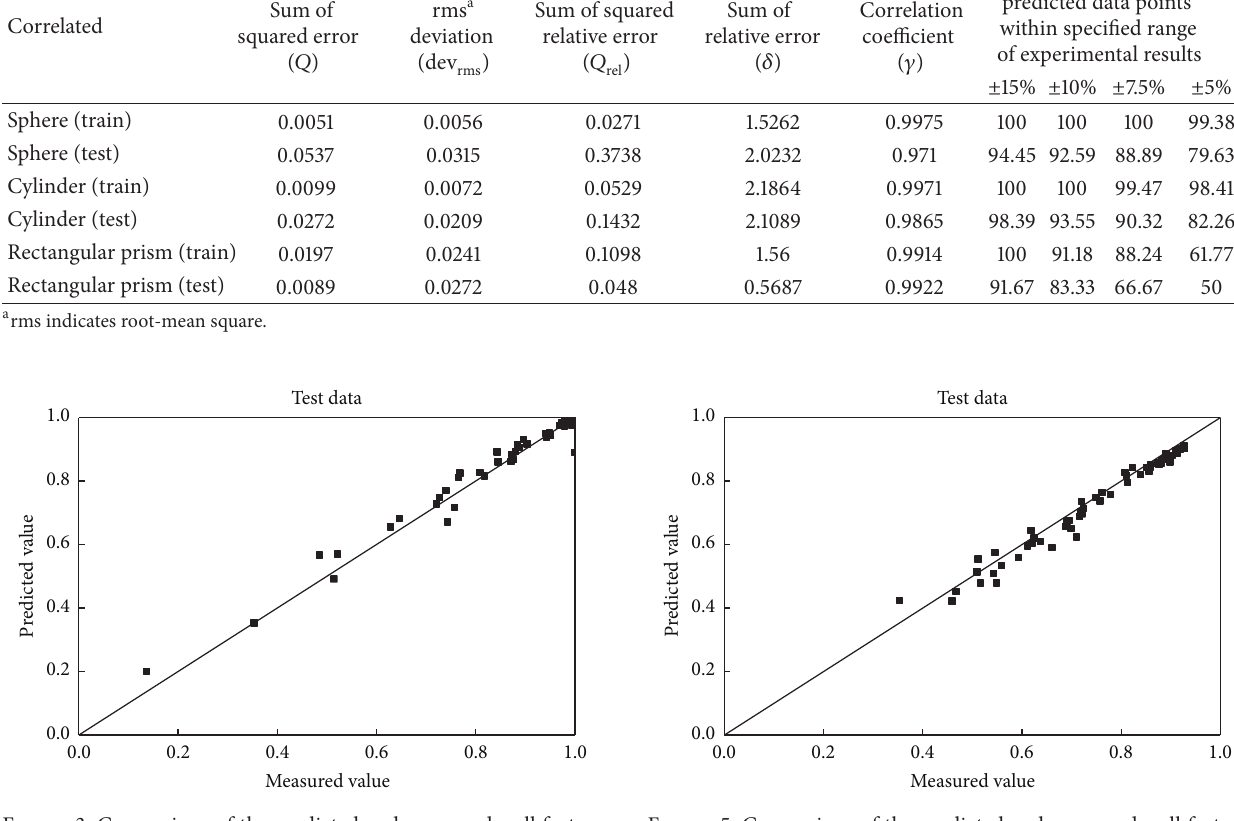
Figure 3: Comparison of the predicted and measured wall factors of spheres for the test data.